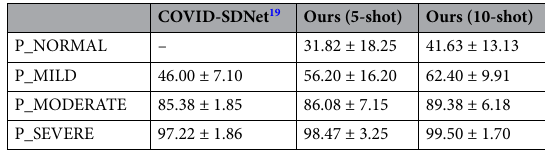
Table 9. Results by severity level on